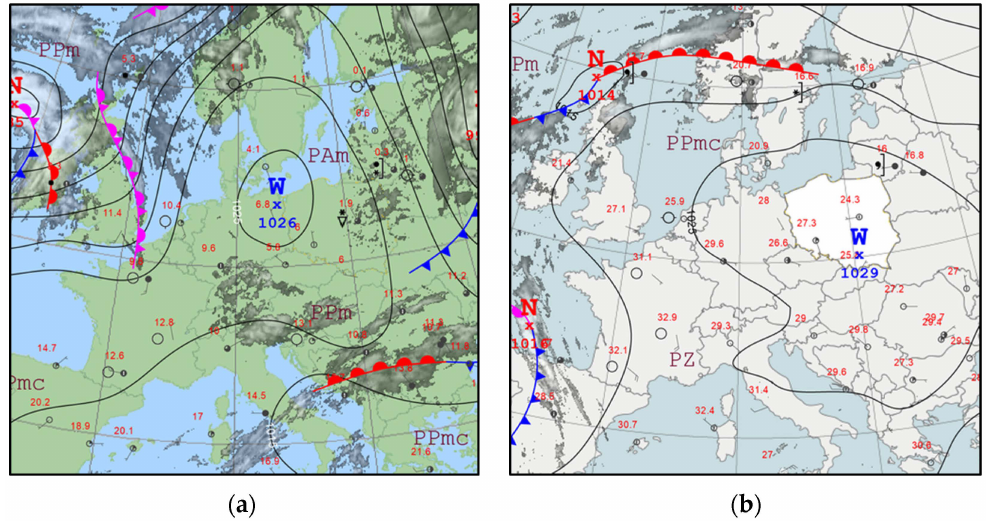
Figure 1. Synoptic maps from IMGW-PIB for the situations of: ( a ) 14 March 2020; and ( b ) 14 September 2020 (high-pressure situation).